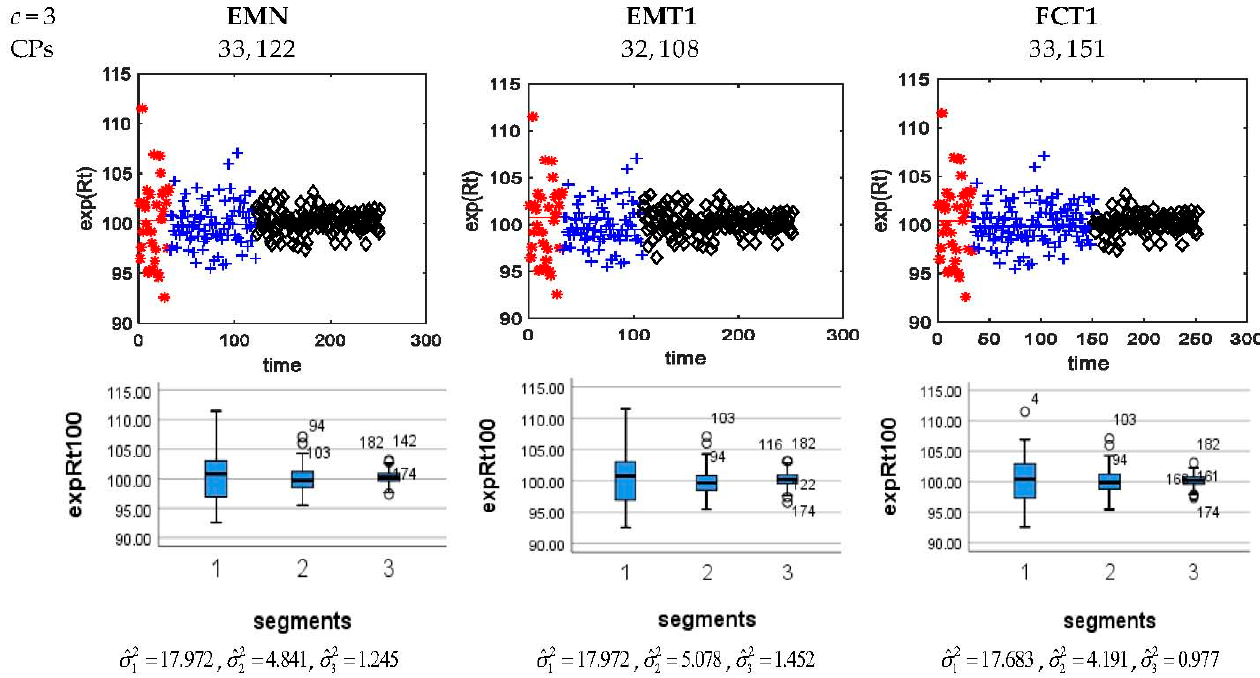
Figure 8. Fitting results of EMN, EMT1 and FCT1 to the 2008 DJIA return series.